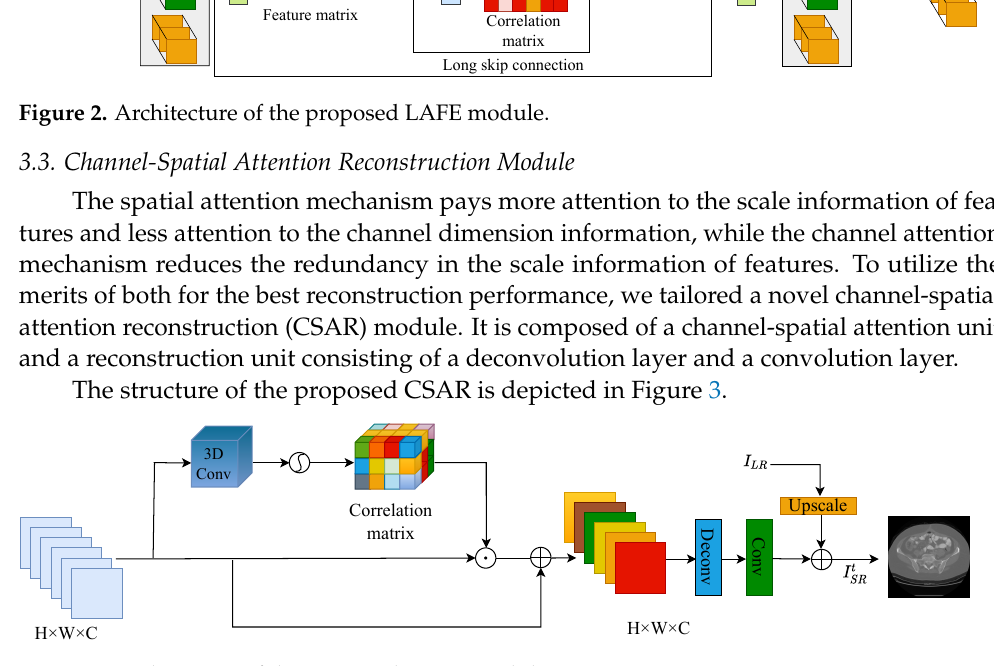
Figure 3. Architecture of the proposed CSAR